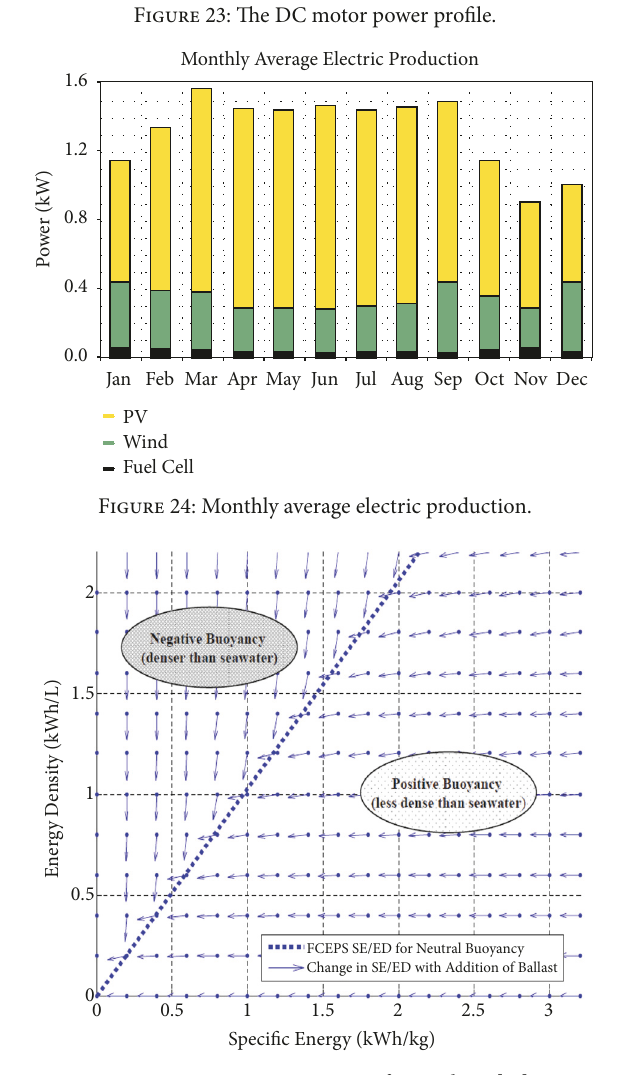
Figure 25: Buoyancy in terms of SE and ED